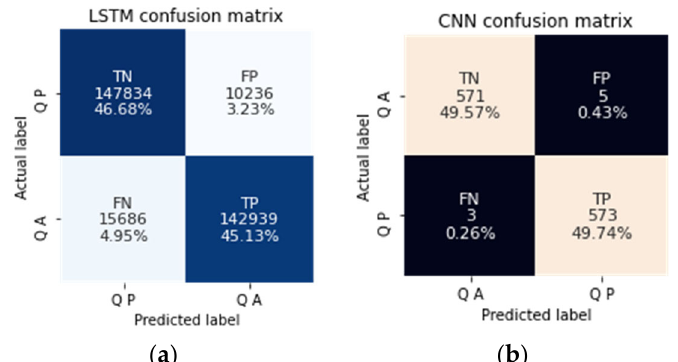
Figure 12. Confusion matrices for ( a ) the LSTM applied to the 14 MFCC features; ( b ) the CNN applied to the STFT spectrograms. QA and QP stands for Queen Absent and Queen Present, respectively. Table 4. Summary Accuracy statistics for the LSTM and CNN models of the original dataset and the Cobham, Surrey dataset we tested our models on. For the original Arnia data, we used 10 ‐ fold cross ‐ validation statistics, and 30 samples from the Surrey dataset were used to test our model.